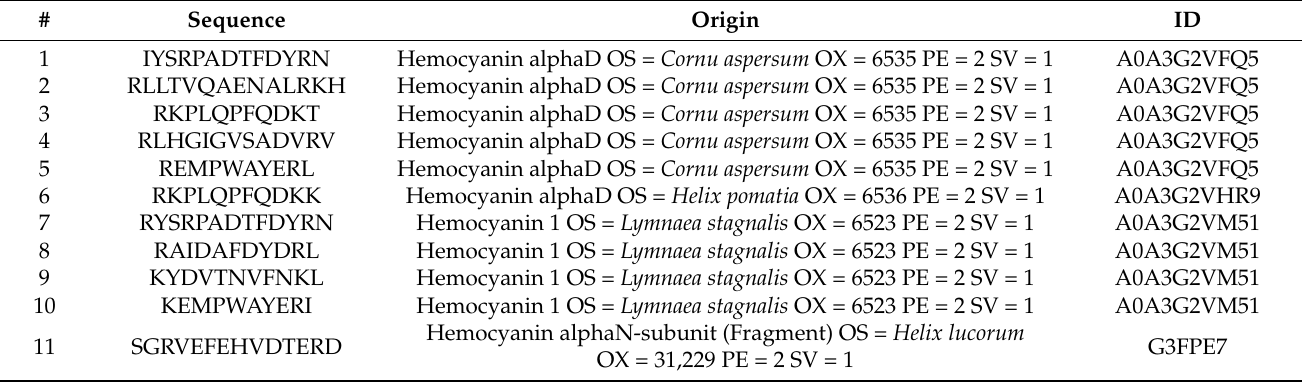
Table 1. Peptides that are part of hemocyanin identified in fraction FMA30 of the mucus secretion of A.